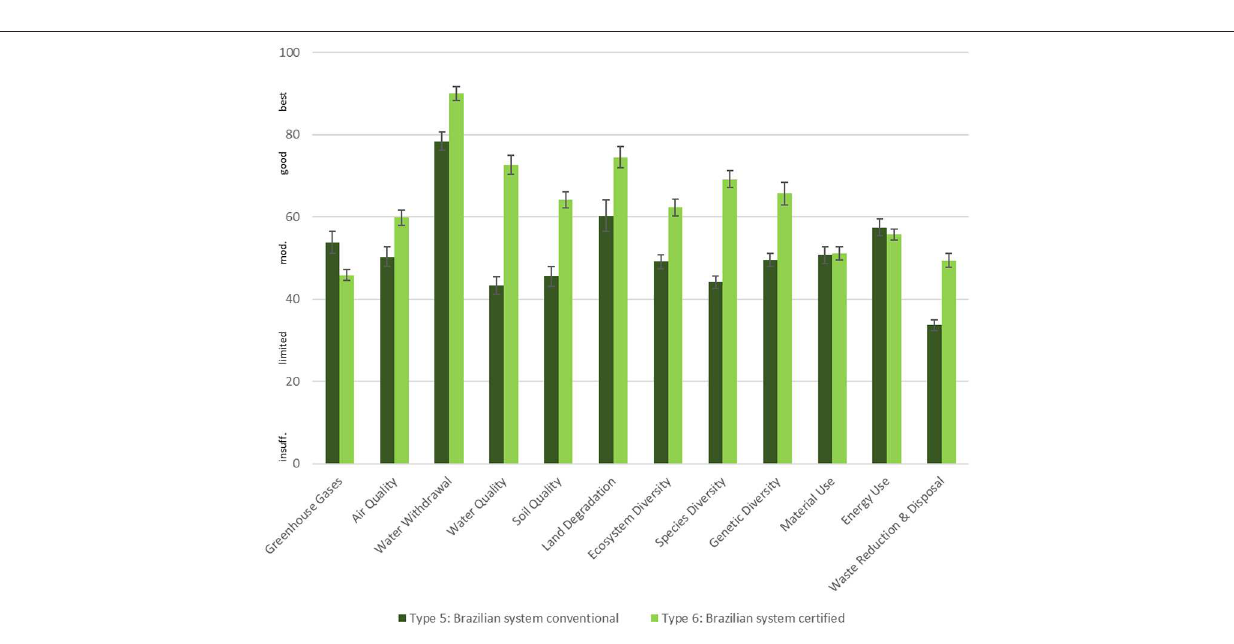
FIGURE 3 | Sustainability performance of typical Brazilian coffee production systems in “Environmental